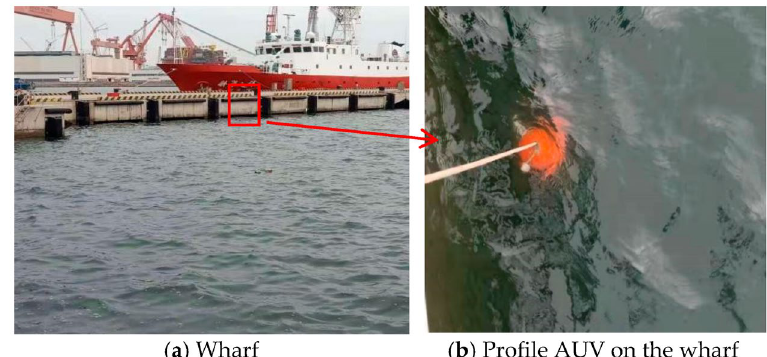
Figure 14. Experiment on the wharf